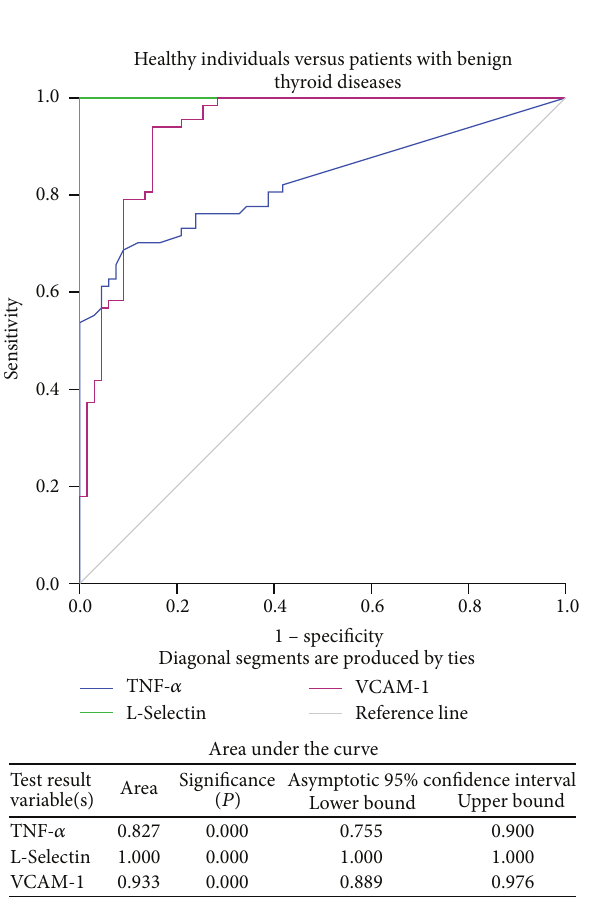
Figure1:ROCcurveforTNF- 𝛼 ,L-Selectin, and VCAM-1inhealthy individuals versus patients with benign thyroid diseases.